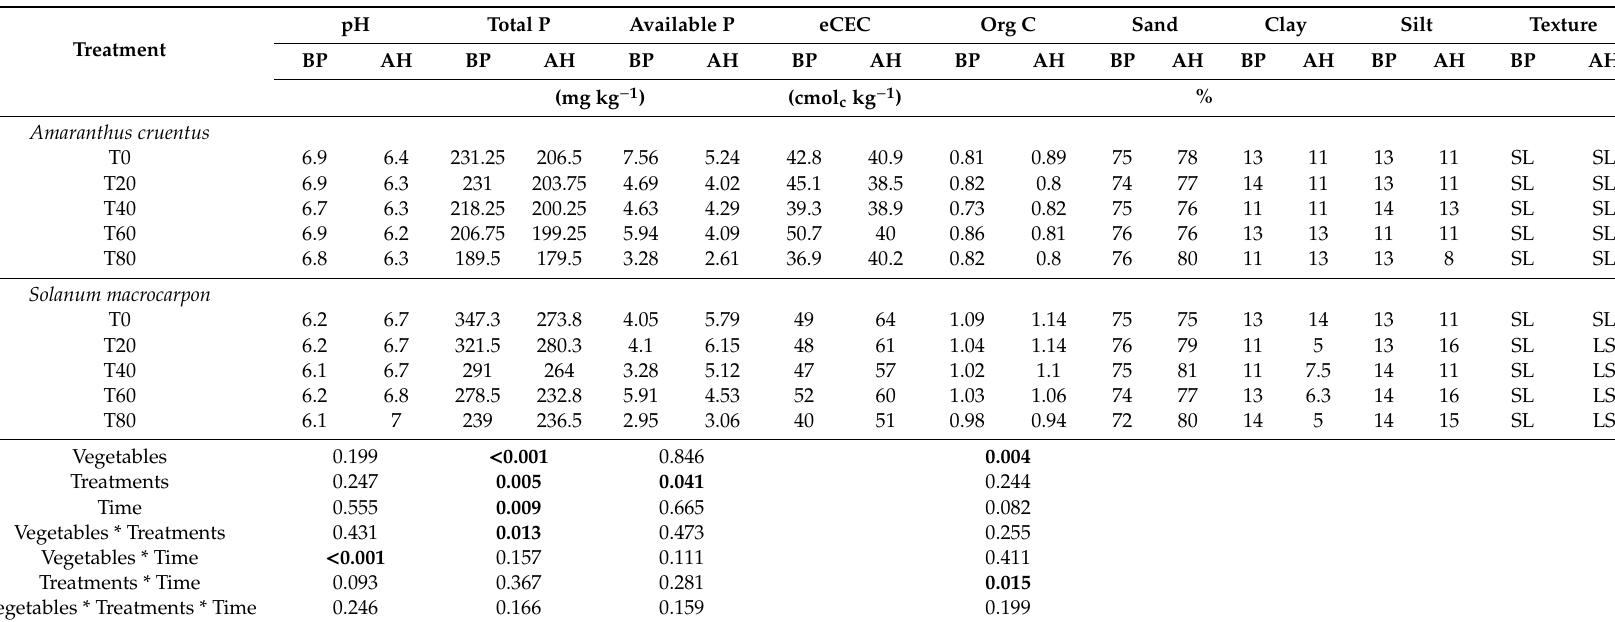
Table 1. Physico-chemical properties of the Ina (dry savanna) soils cultivated with Amaranthus cruentus and Solanum macrocarpon ( n = 4). eCEC, estimated cation exchange capacity; BP, before planting; AH, after